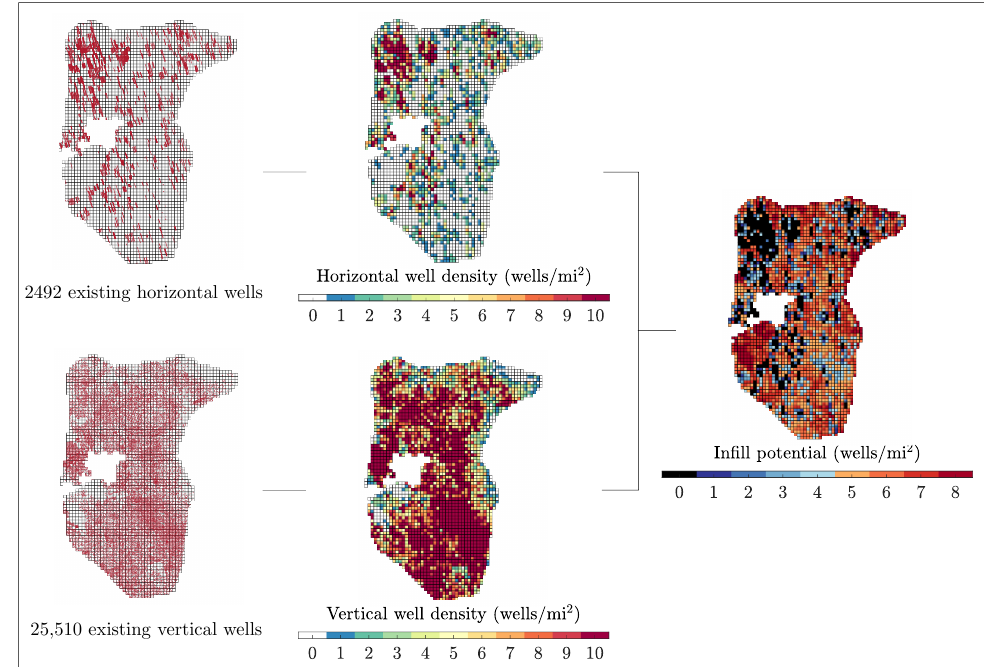
Figure 12. An example of the procedure to calculate the infill potential of the Midland Spraberry Core. We first calculate well densities from all existing 2492 horizontal and 25,510 vertical wells. The vertical well density is then converted to its equivalent horizontal well density. The infill potential is calculated as the maximum allowable number of wells to prevent frac hits minus the total existing well